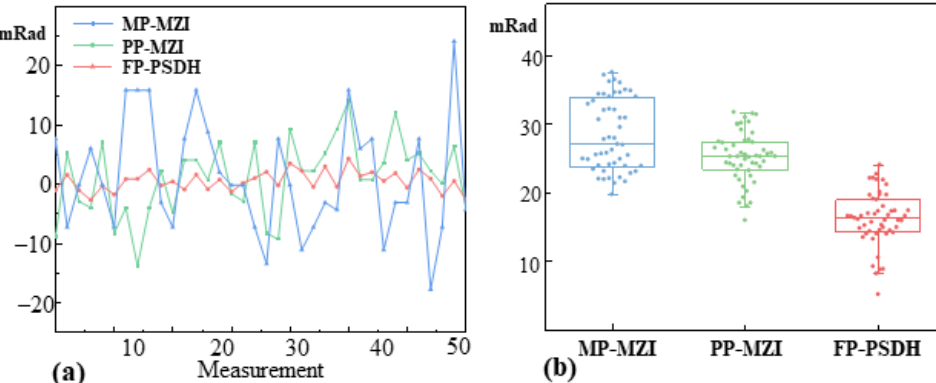
Figure 6. Quantitative evaluation of system stability and sensitivity: ( a ) Temporal stability evaluation of MP-MZI, PP-MZI, and FP-PSDH. The X-axis represents the time sequential measurements, and the Y-axis represents the respective phase fluctuations for a specific point in the recovered phase map; ( b ) Spatial sensitivity evaluation of MP-MZI, PP-MZI, and FP-PSDH with the respective box plots. In each box plot, the lower and upper boundaries represent the first and third quartiles, respectively, and the line in each box represents the median value. Table 1. Quantitative comparison of FP-PSDH system performance with MP-MZI and PP-MZI tech- niques.